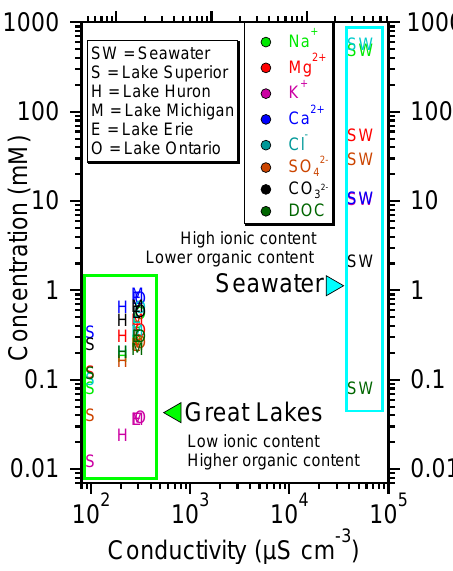
Figure 1. Concentration vs. conductivity vs. of important ions ) for freshwater (Na + , Mg 2 + , K + , Ca 2 + , Cl − , SO 2 − , and CO 2 − 4 3 (Great Lakes) and mean seawater, as well as DOC. Great Lakes ion concentrations and conductivity are from Chapra et al. (2012), and seawater ion concentrations and conductivity are from Pil- son (2013). TOC values for the Great Lakes are from Repeta et al. (2002), Shuchman et al. (2013), and Biddanda and Cot- ner (2002), while the TOC value for seawater is from Repeta et al. (2002). Note: K + is fully obscured for seawater by Ca 2 +